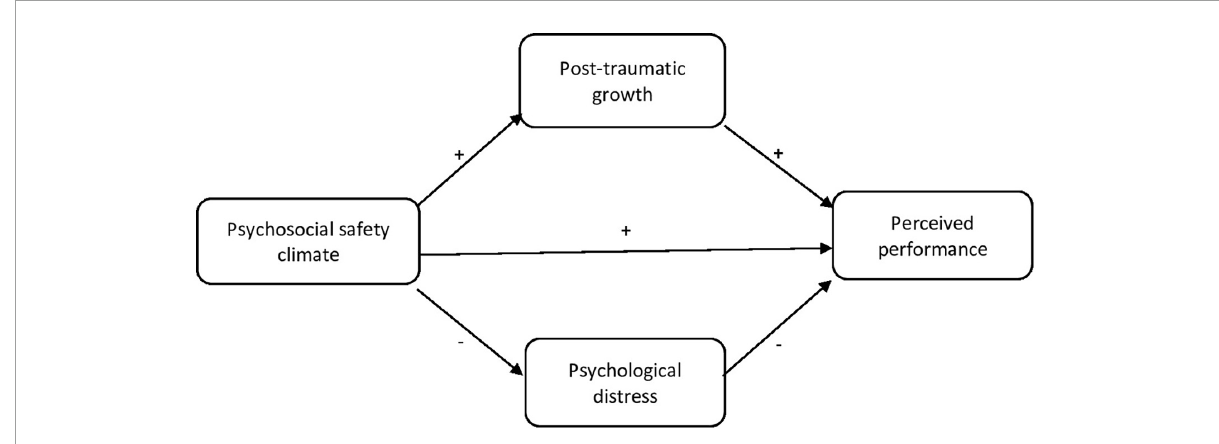
FIGURE1 Theoretical